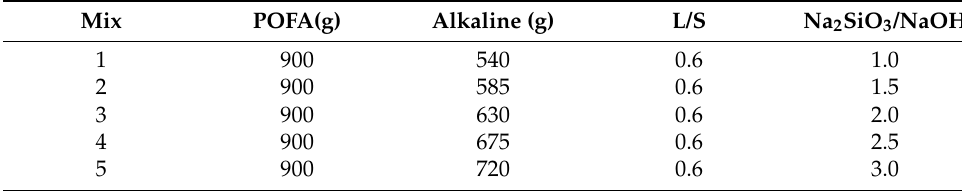
Table 2. Mixing proportions using various alkaline activator